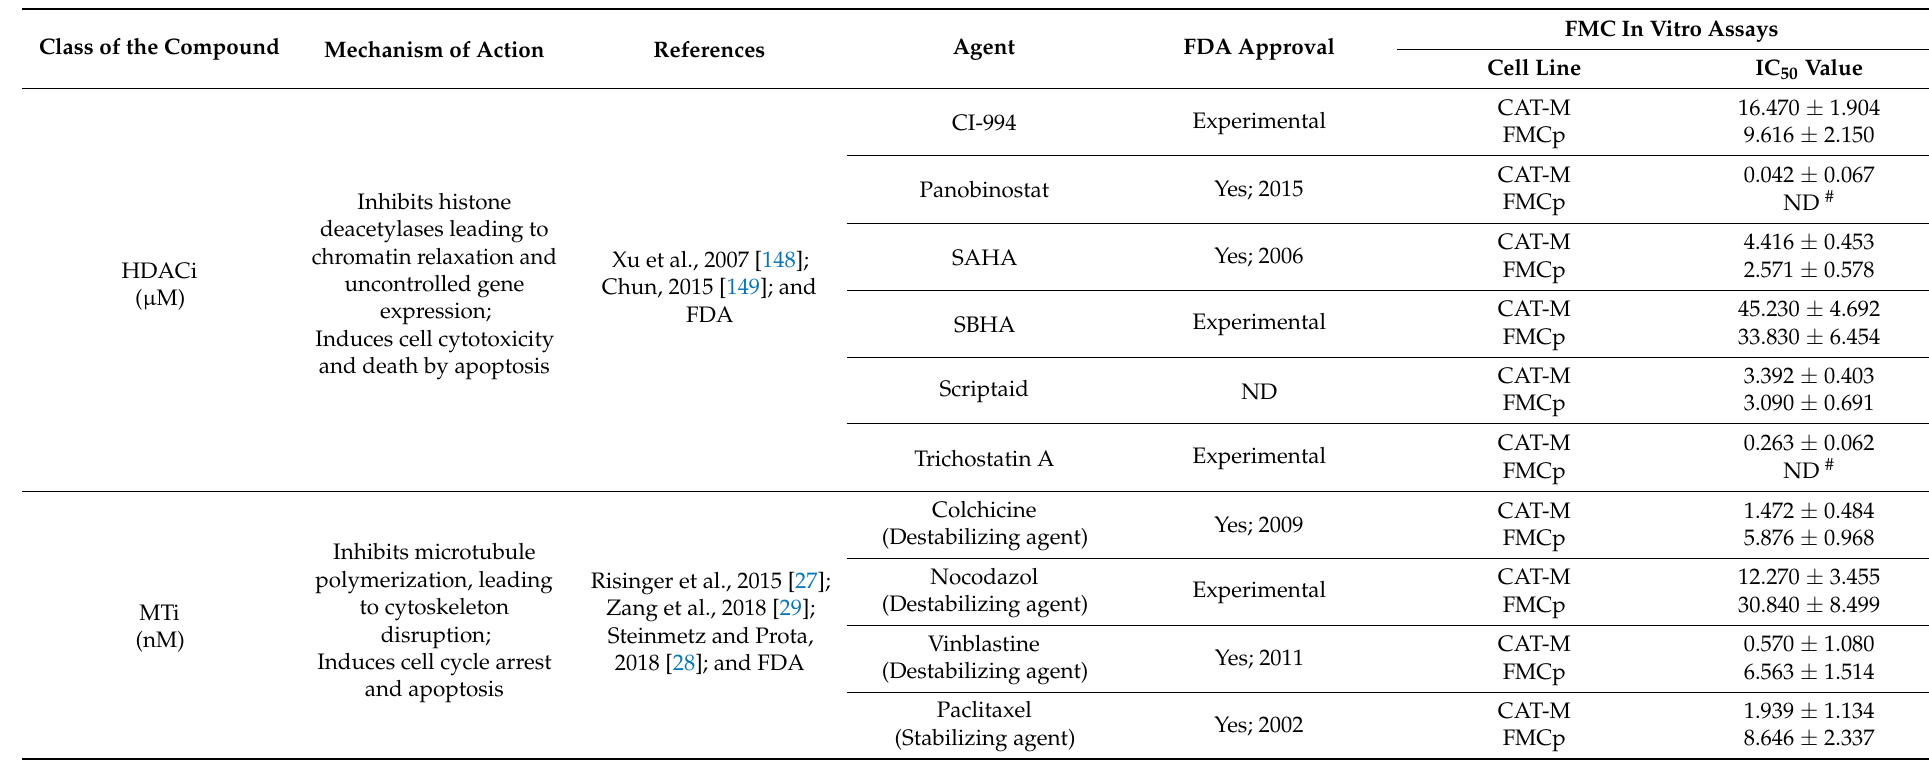
Table 6. Histone deacetylase inhibitors and microtubule inhibitors show promising cytotoxic effects in FMC cell-based models, suggesting a conserved mechanism of action [9]. Class of the